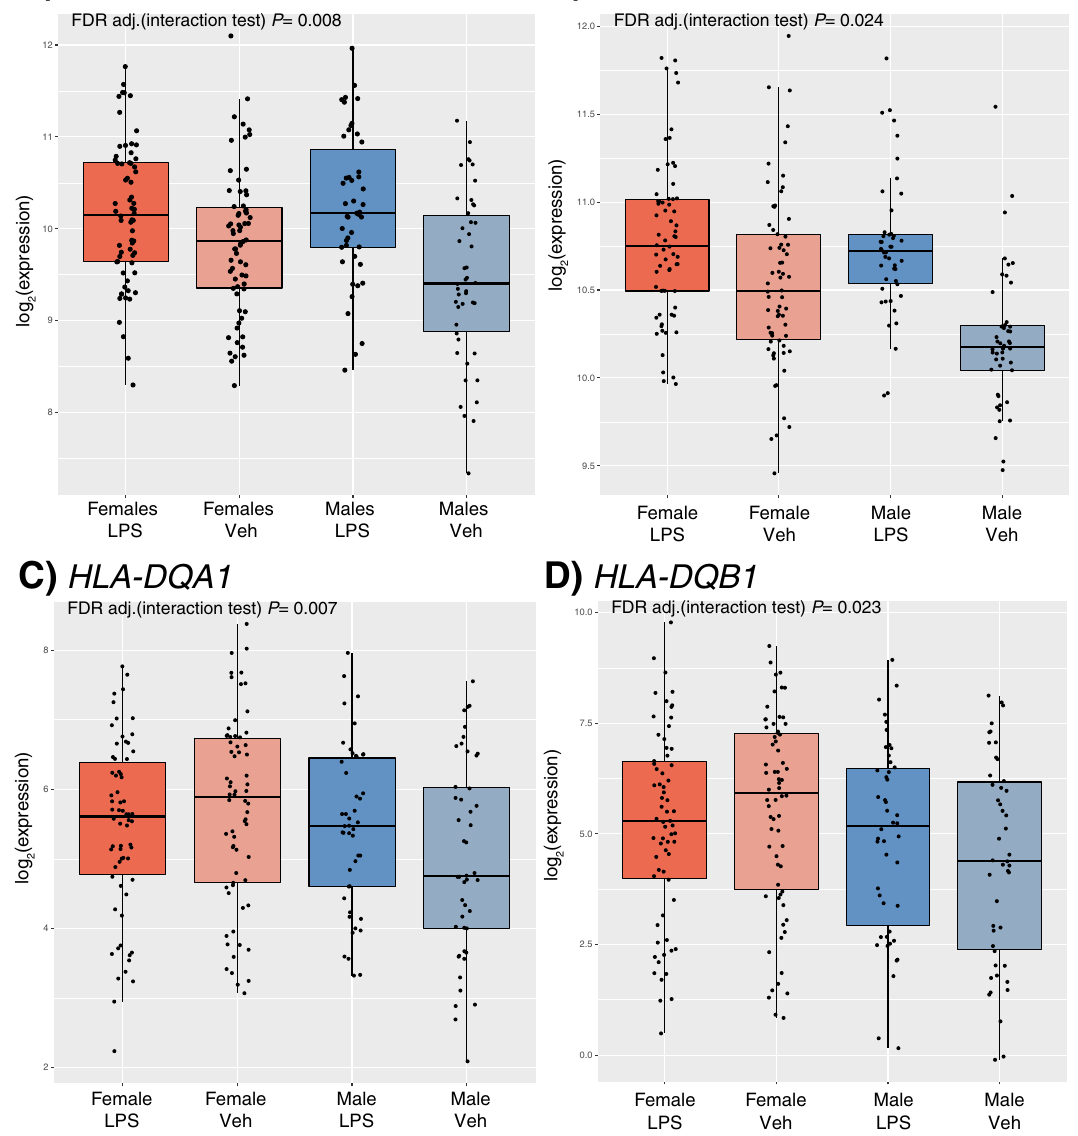
Figure 7. Boxplots illustrating four HLA genes with significant sex by treatment interactions. ( A ) HLA-A and ( B ) HLA-B are examples of genes where the magnitude of response differs between males and females. ( C ) HLA- DQA1 and ( D ) HLA-DQB1 show opposite directions of response to LPS treatment in males and